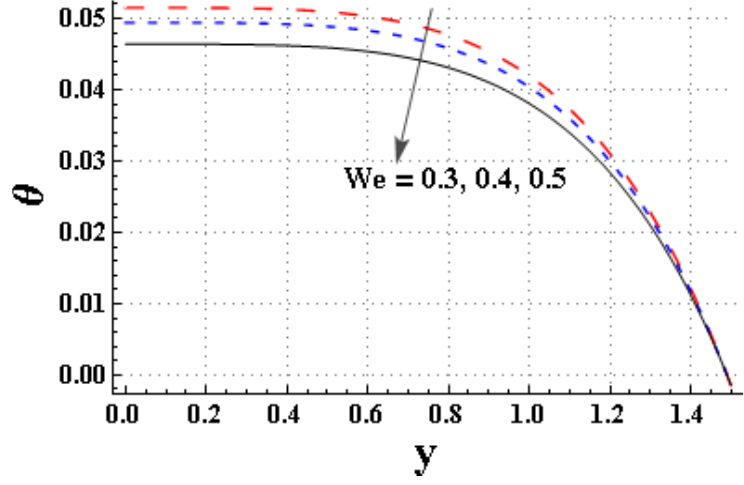
Figure 9. Effect of the Weissenberg number, We , on temperature, θ